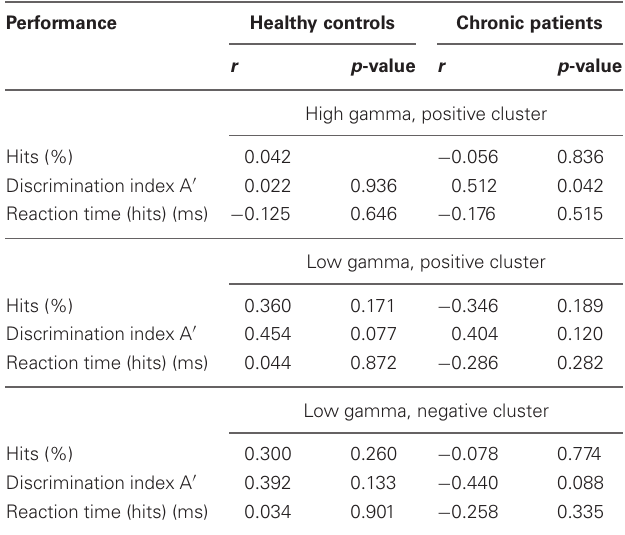
Table 4 | Correlations between gamma-band power and